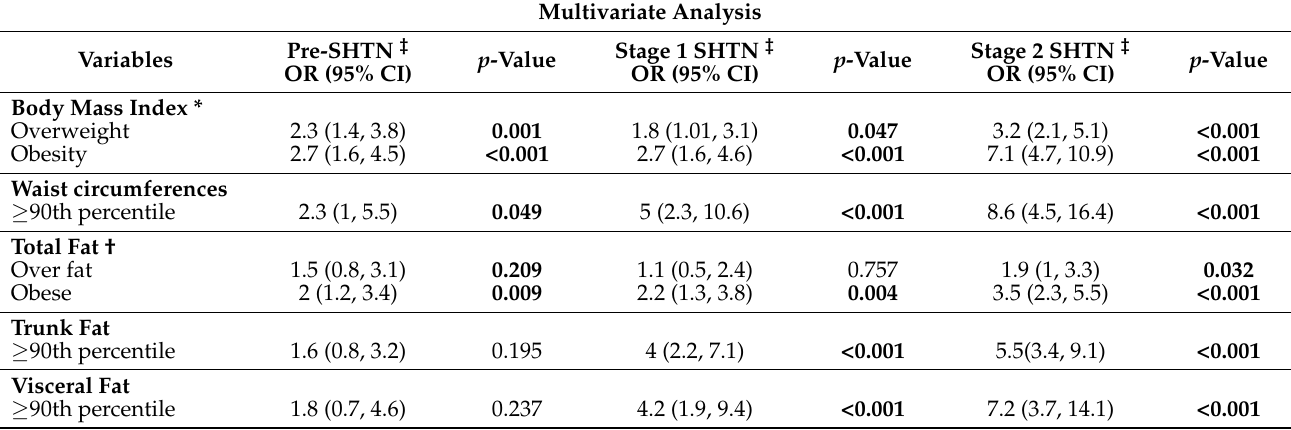
Table 3. Multivariate logistic regression between adolescent’s systolic hypertension and anthropometric measurements. Multivariate